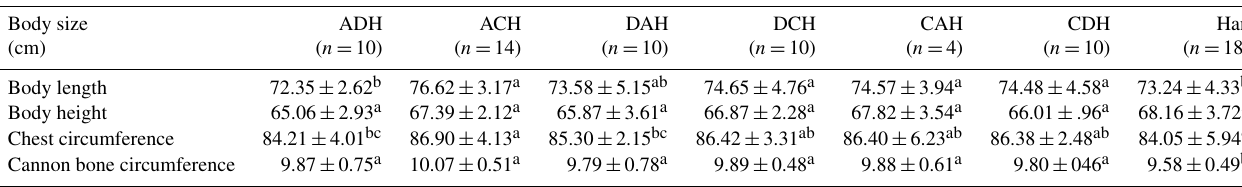
Table A4. The result of variance analysis of body size parameters of three-way crossbred and Han lambs at 6 months of age (mean ± standard